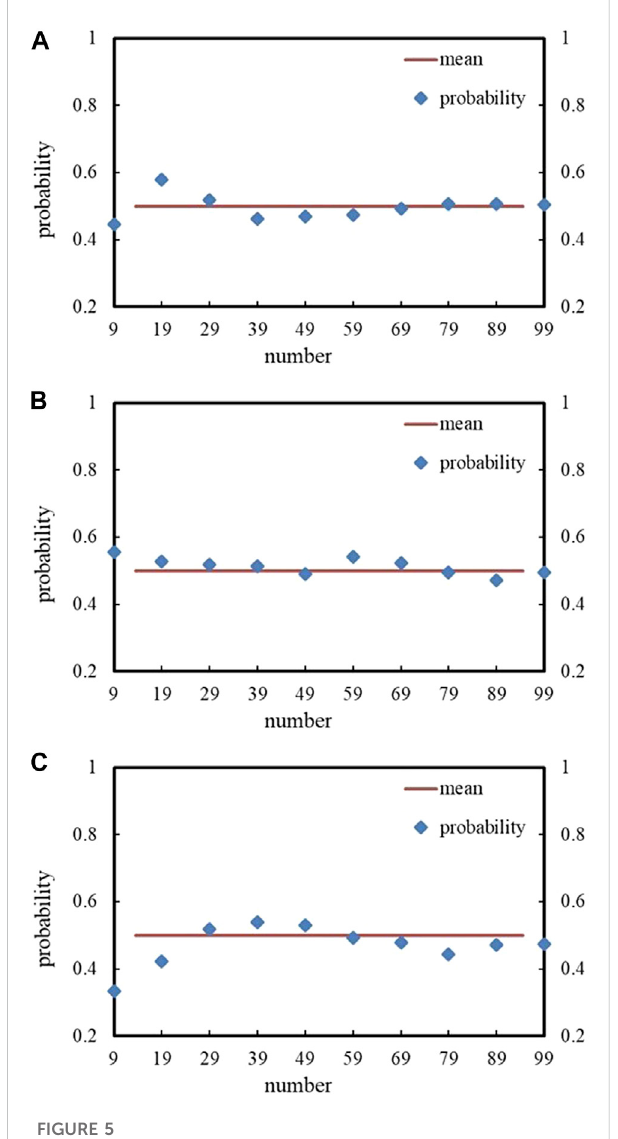
The 3 trials of random coin tossing from (A – C) .